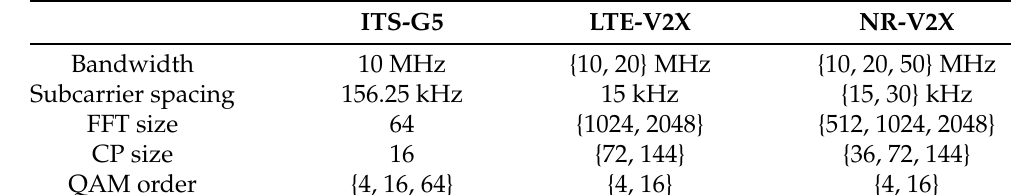
Table 1. PHY layer parameters of generated vehicular communication signals.